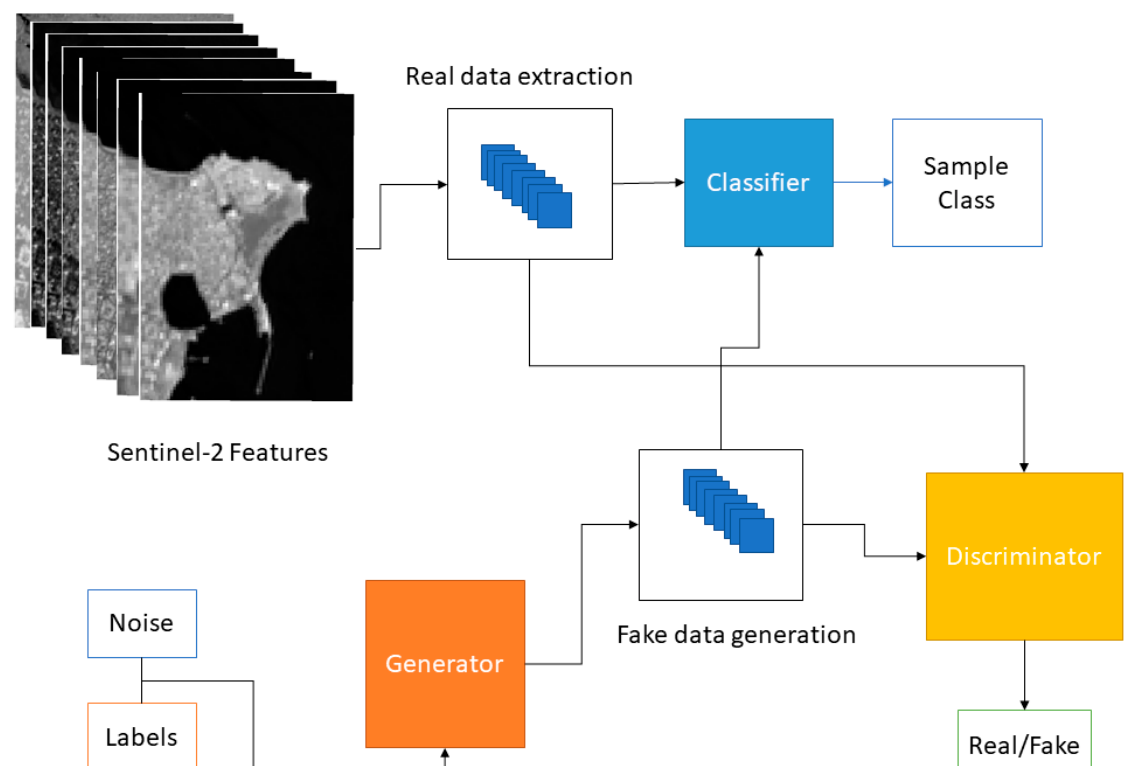
Figure 6. The architecture of the GAN model.